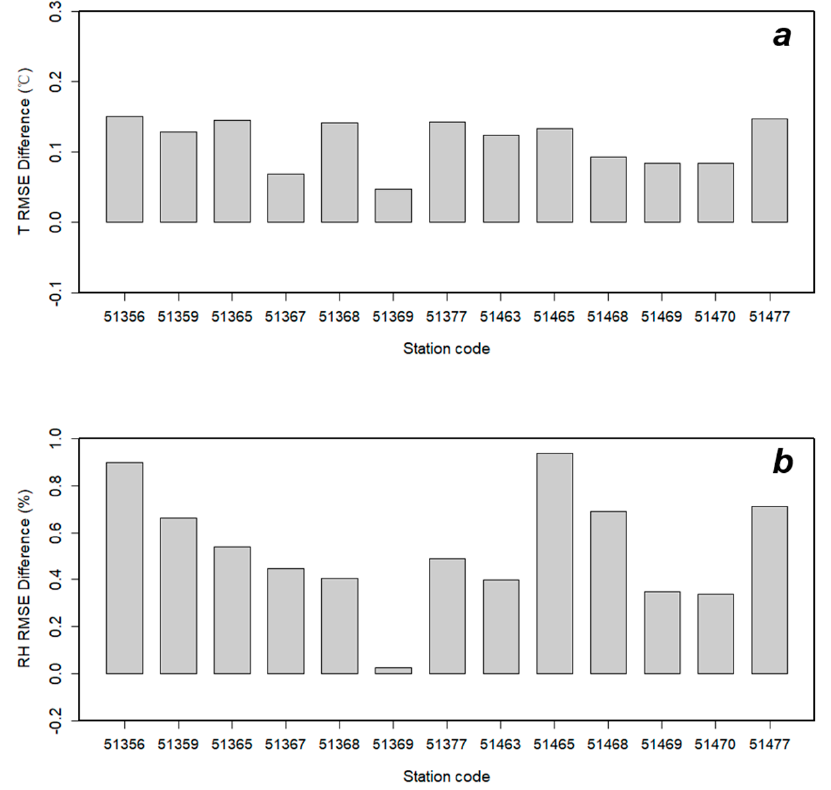
Figure 8. Difference between the RMSE values of post-correction forecasts for: ( a ) temperature and ( b ) relative humidity by AutoML model and random forest model.